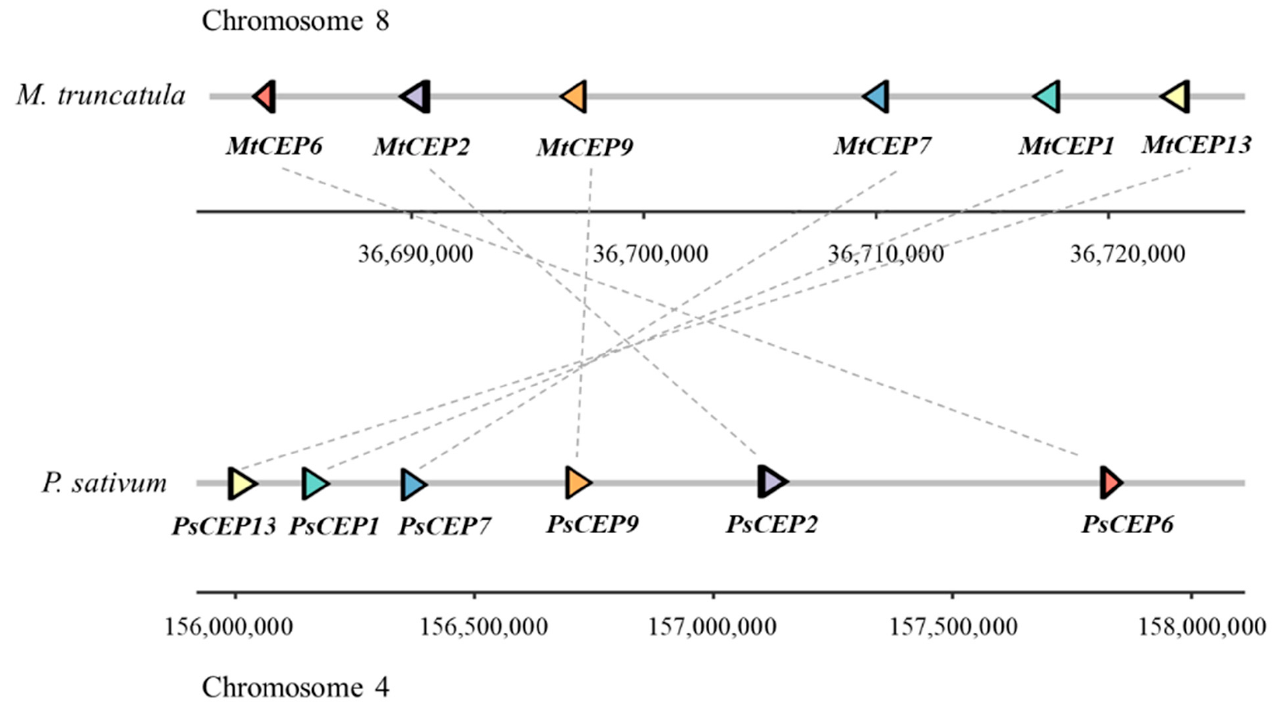
Figure 3. Microsynteny of the genomic regions bearing the cluster of the CEP genes in M. truncatula and P. sativum . The positions of the orthologous genes are shown with the triangles of the same color and are connected with dotted